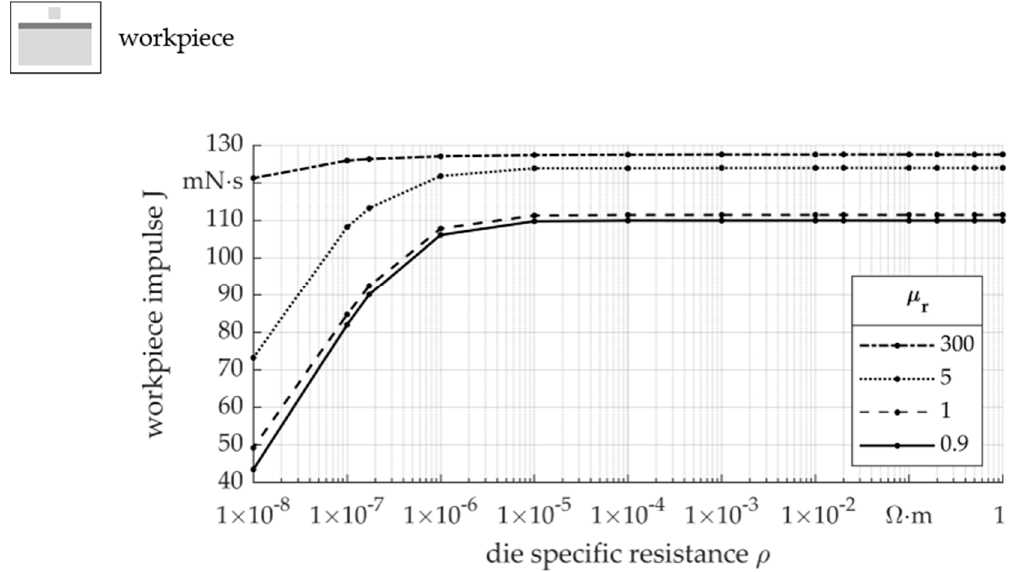
Figure 6. Simulated impulse J on thin aluminium sheets for different electromagnetic properties of the die material.